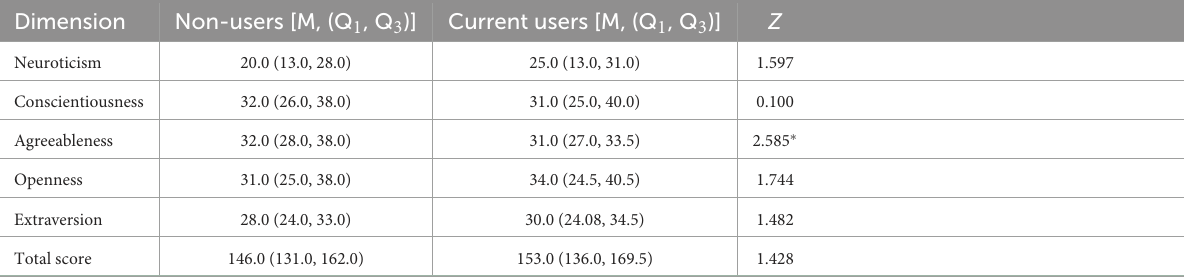
TABLE 3 Comparison of the personality traits between non-users and current users.